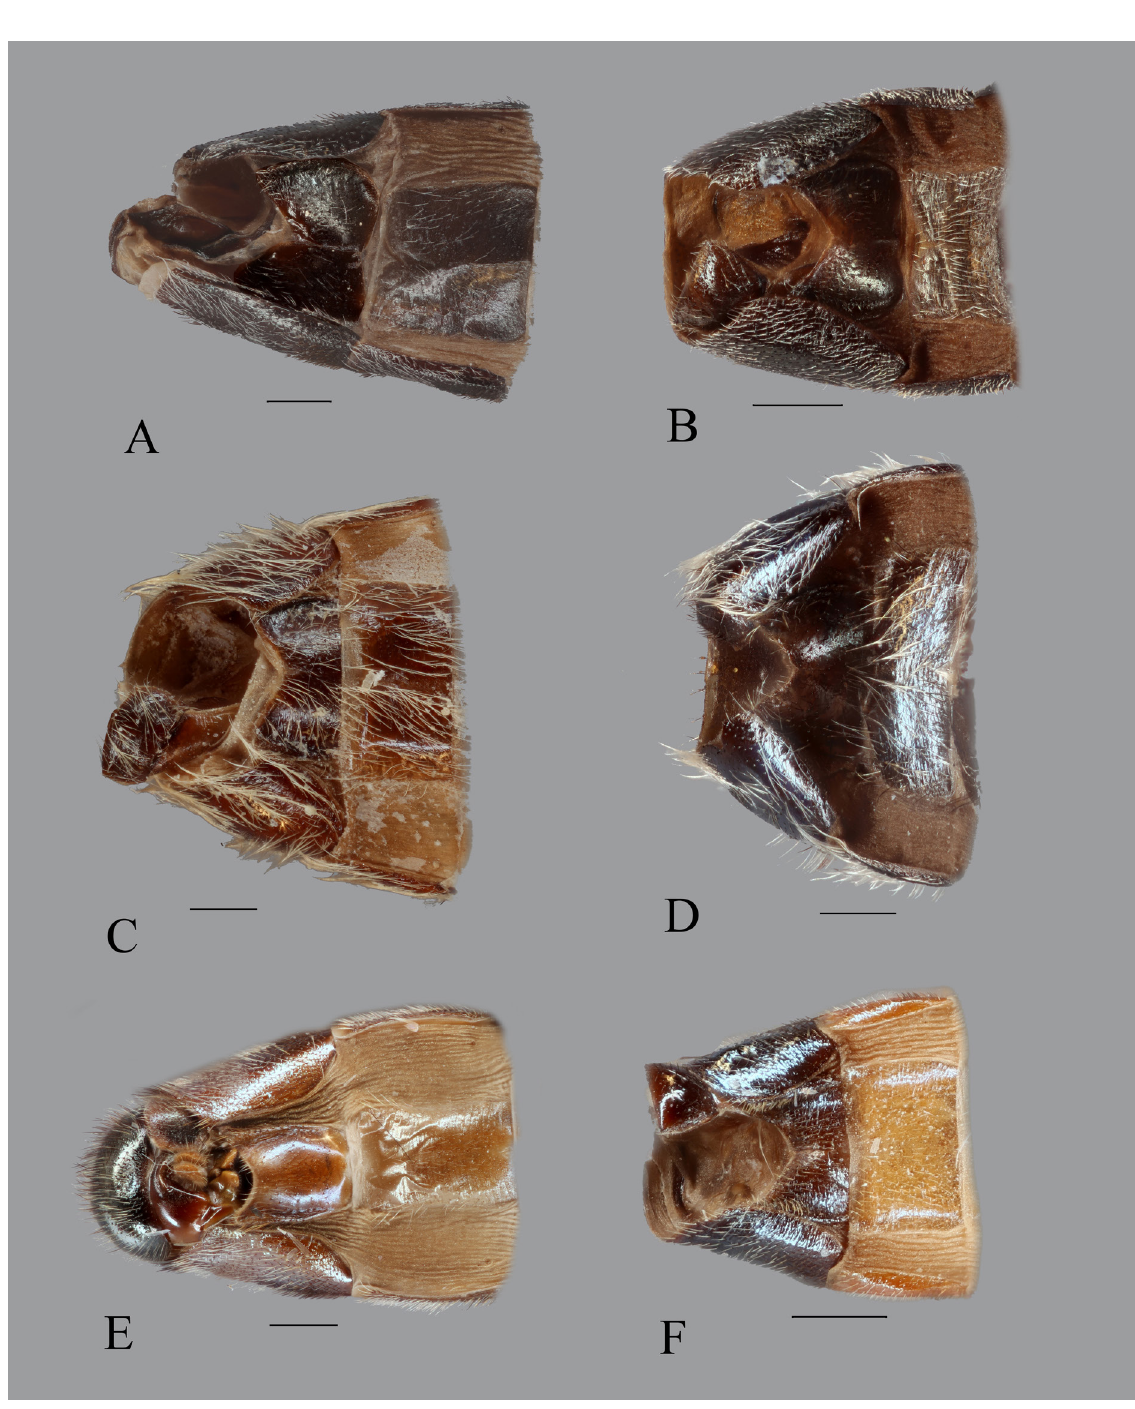
Fig. 12. Sternum IV, ♂, ventral view. A . Eumerus atricolorus Gilasian & van Steenis sp. nov., holotype (HMIM). B . E. brevipilosus Gilasian & van Steenis sp. nov., holotype (HMIM). C . E. chekabicus Gilasian & van Steenis sp. nov., holotype (HMIM). D . E. hissaricus Stackelberg, 1949, Ghoochan, Iran (HMIM). E . E. pilosipedes Gilasian & van Steenis sp. nov., holotype (HMIM). F . E. vallicolus Gilasian & van Steenis sp. nov., holotype (HMIM). Scale bars = 0.5